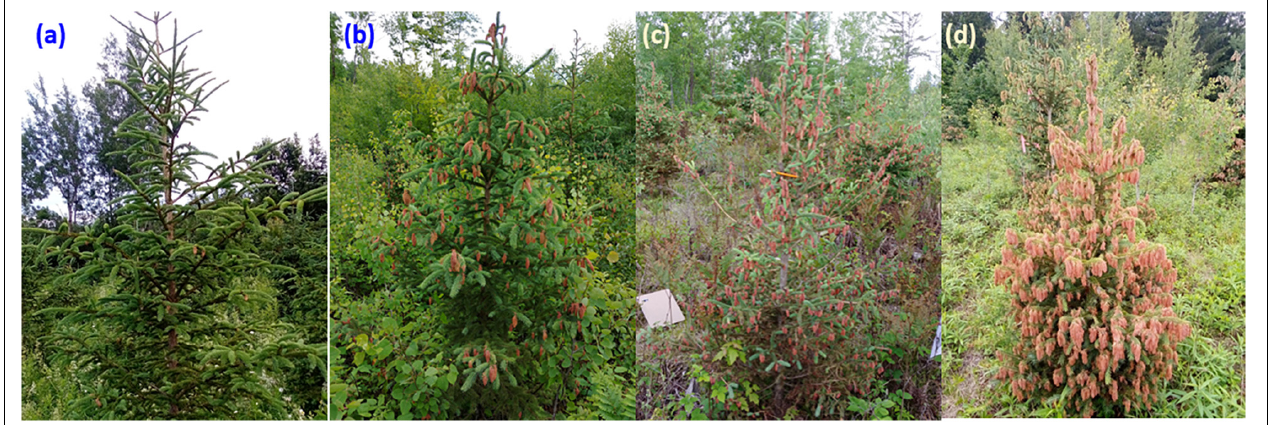
FIGURE 2 | Classification of 2021 late-spring frost damage severity: trees with (a) no damage, (b) low damage, (c) moderate damage, and (d) severe damage.